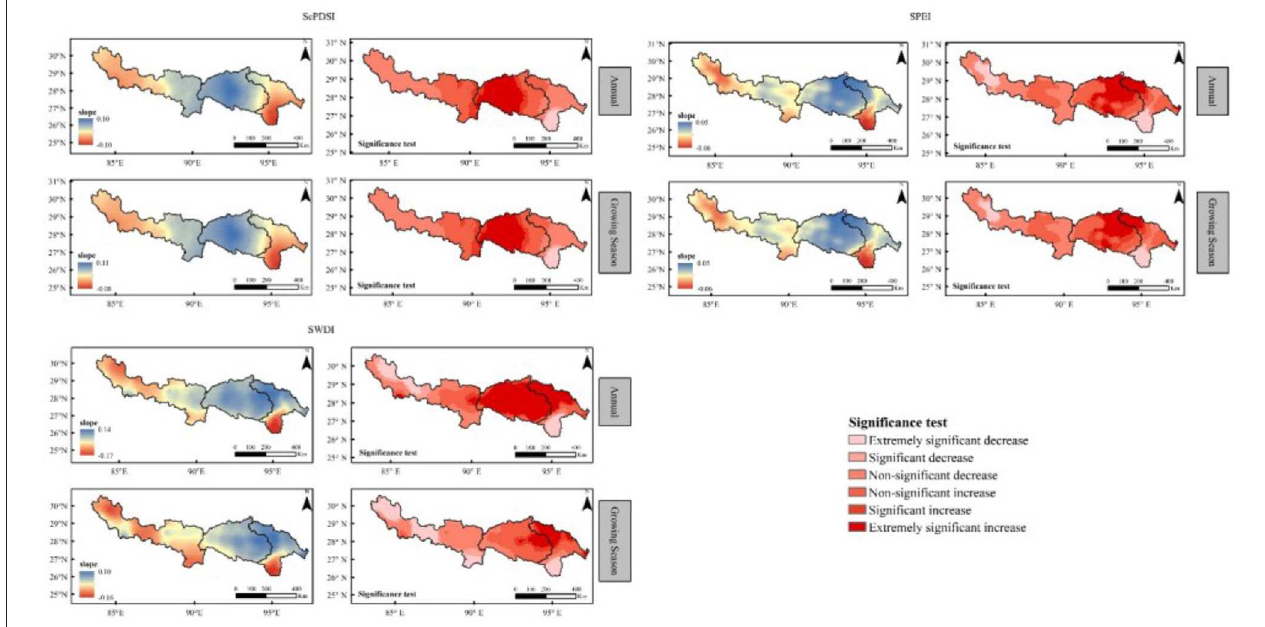
FIGURE 5 | Annual and growing season variation trends of three drought indices with the significance